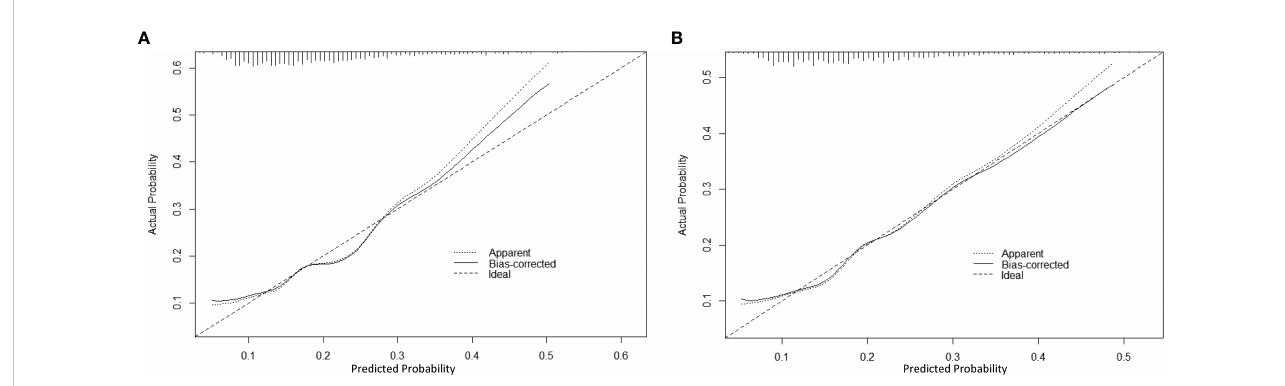
FIGURE 5 The calibration curve of the nomogram for predicting GDM in the training dataset and validation dataset, respectively. Calibration focused on the accuracy of the probability between the predictive model and the actually observed value. The y -axis represents the actual diagnosed cases of GDM, the x -axis represents the predicted risk of GDM, and the solid line represents the prediction of the training dataset (A) and the validation dataset (B) .